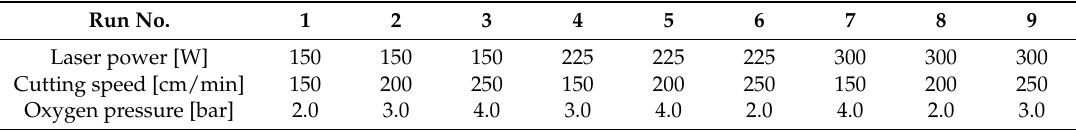
Table 2. L 9(3 4 ) orthogonal array defining the cutting conditions used during the experimental tests. Run No.